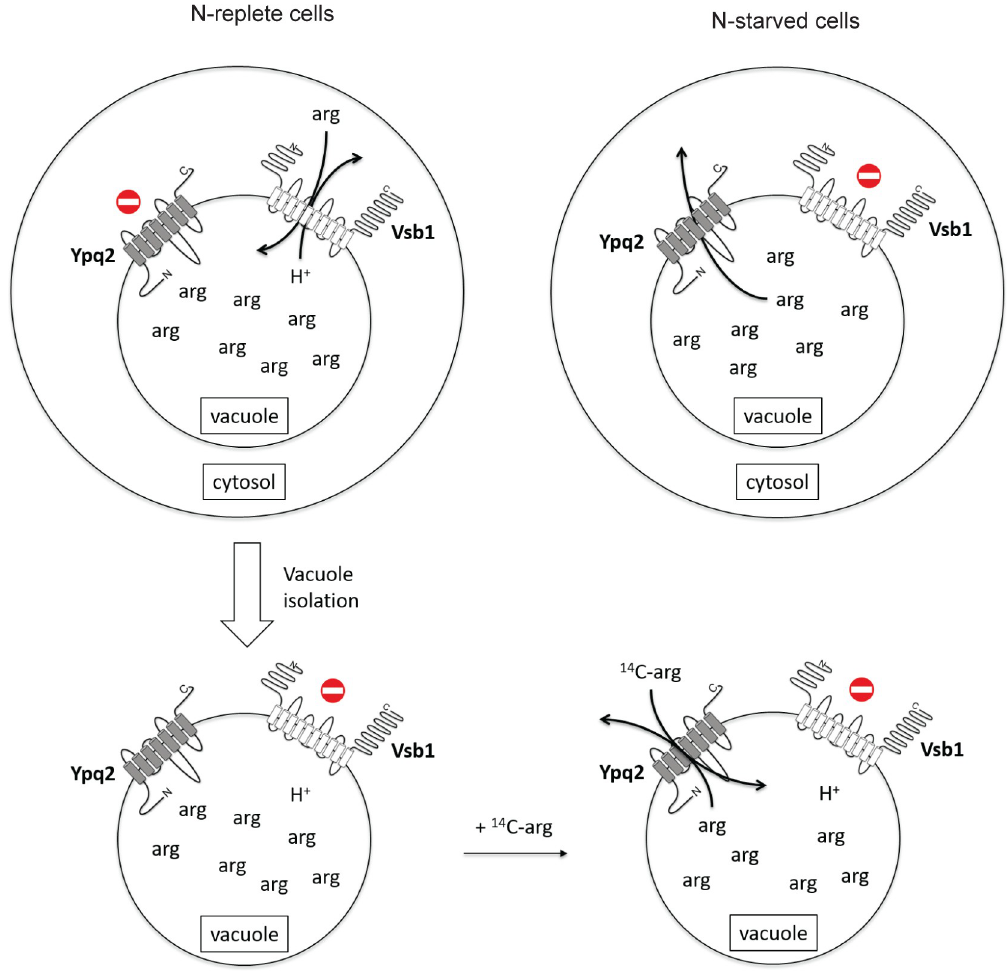
Fig 9. Model for the coordinated import and export of Arg across the vacuolar membrane. In N-replete cells, Vsb1 is active and promotes Arg uptake into the vacuole, probably through a proton antiport mechanism. The Ypq2 export protein is maintained inactive so that Arg is sequestered and accumulates in the vacuole. When cells are transferred to an N-free medium, Vsb1 is inactivated while Ypq2, which becomes active, mobilizes the intravacuolar Arg to the cytosol, where it is used as an N source. This Arg export likely corresponds to a uniport reaction. During the procedure for isolating vacuoles, cells pregrown under N-replete conditions undergo harsh conditions causing inactivation of Vsb1 and concomitant activation of Ypq2, as occurs under N starvation conditions. Measured uptake of 14 C-Arg in those vacuoles is thus mainly mediated by Ypq2, catalyzing a 14 C-Arg/Arg exchange reaction.